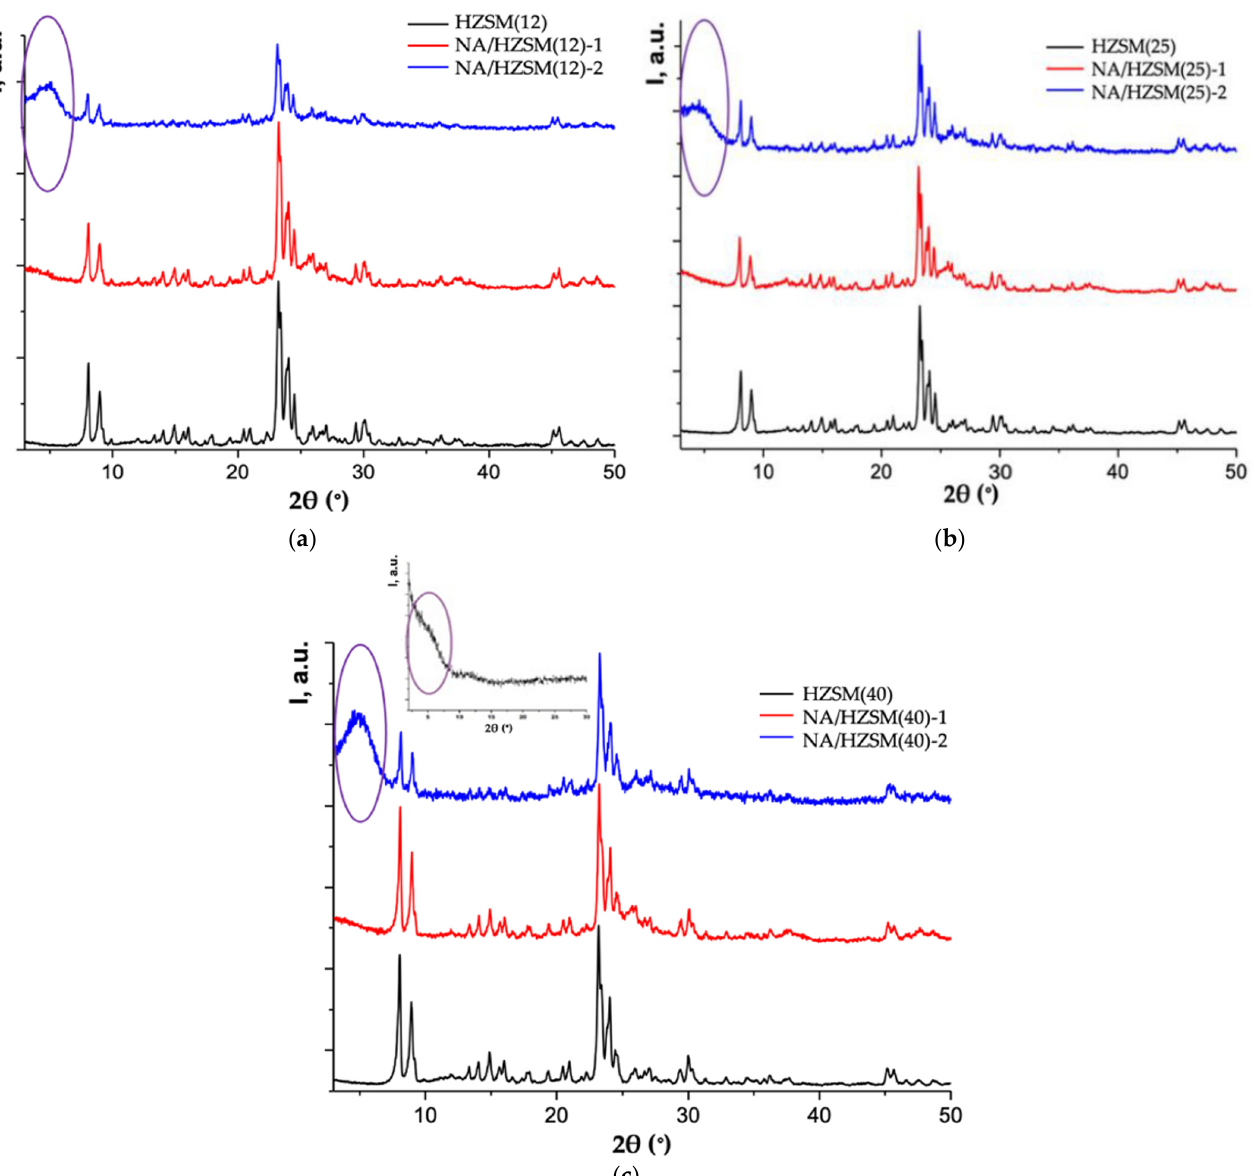
Figure 5. X-ray patterns of HZSM and NA/HZSM-1, 2 with Si/Al = 12 ( a ), 25 ( b ), 40 ( c ). Inset in ( c )—X-ray pattern of dried and powdered titanium tetrabutoxide Ti( С 4 H 9 O) 4 ( λ —1.54051 Å) (adapted from [16]).